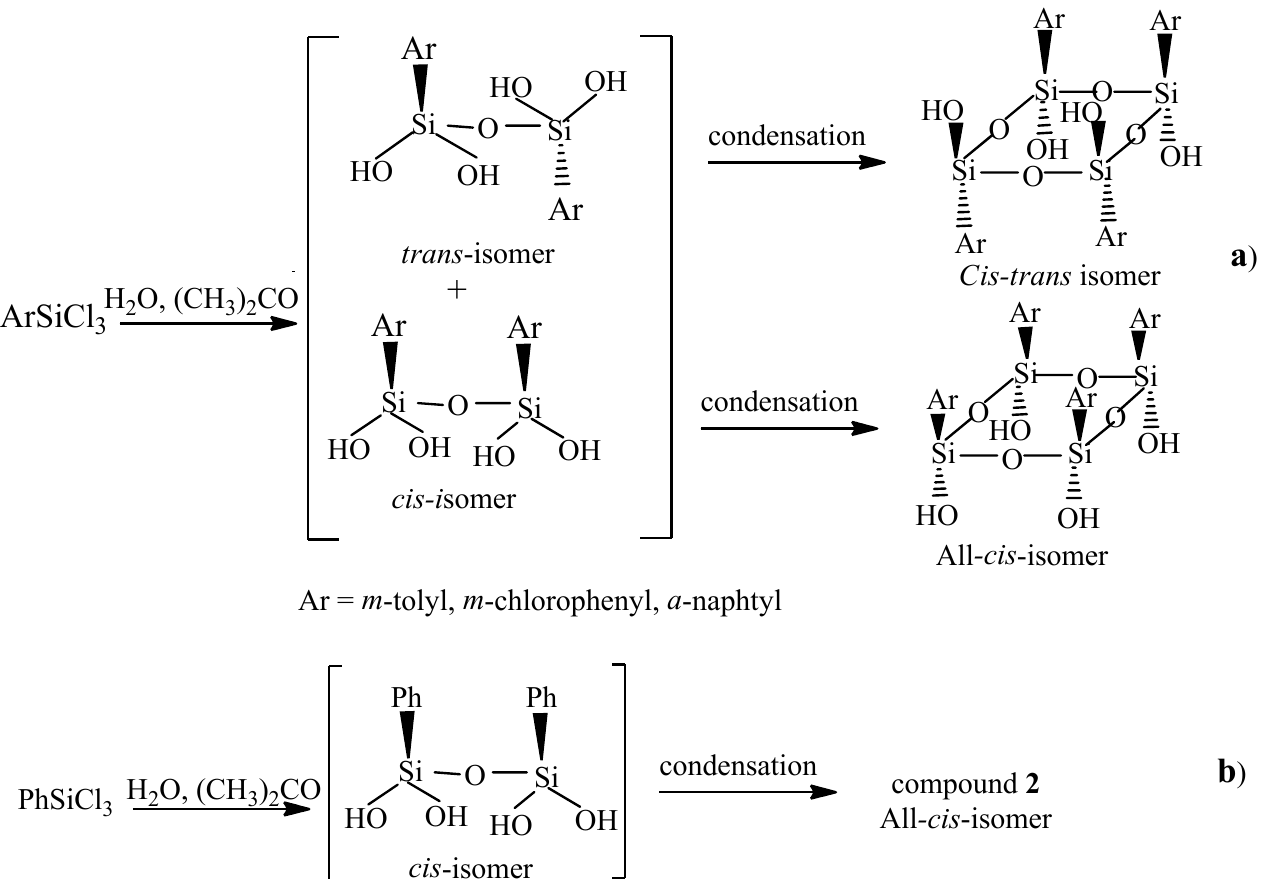
Scheme 1. The ways of formation of stereoisomers of (tetrahydroxy)(tetraaryl)cyclotetrasiloxanes in the